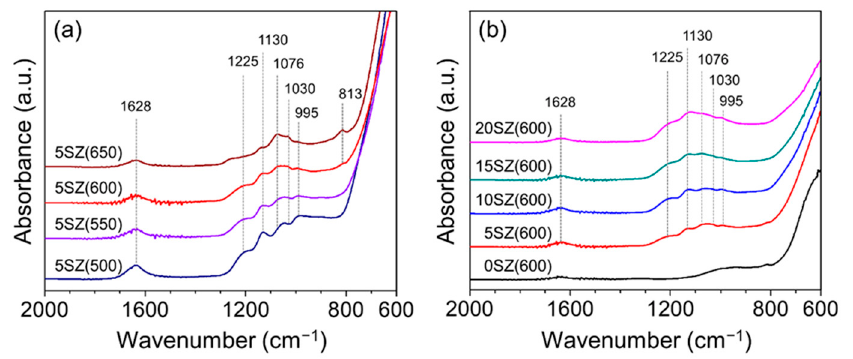
Figure 3. FTIR spectra of ( a ) 5SZ( y ) and ( b ) x SZ(600) catalysts prepared at different calcination temperatures and sulfate contents, respectively.